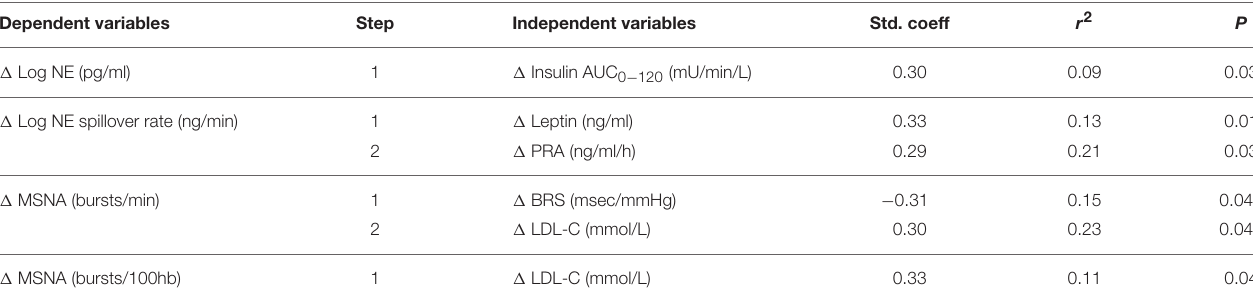
TABLE 3 | Stepwise regression analyses of changes in sympathetic neural parameters following hypocaloric diet. Dependent